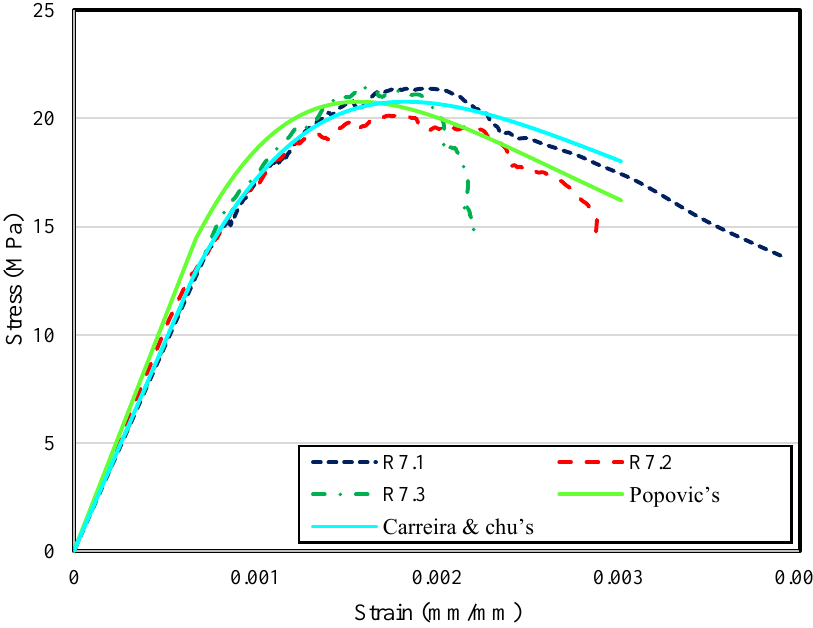
Figure 22. Comparison of stress-strain curves of R7 mix with existing constitutive models.